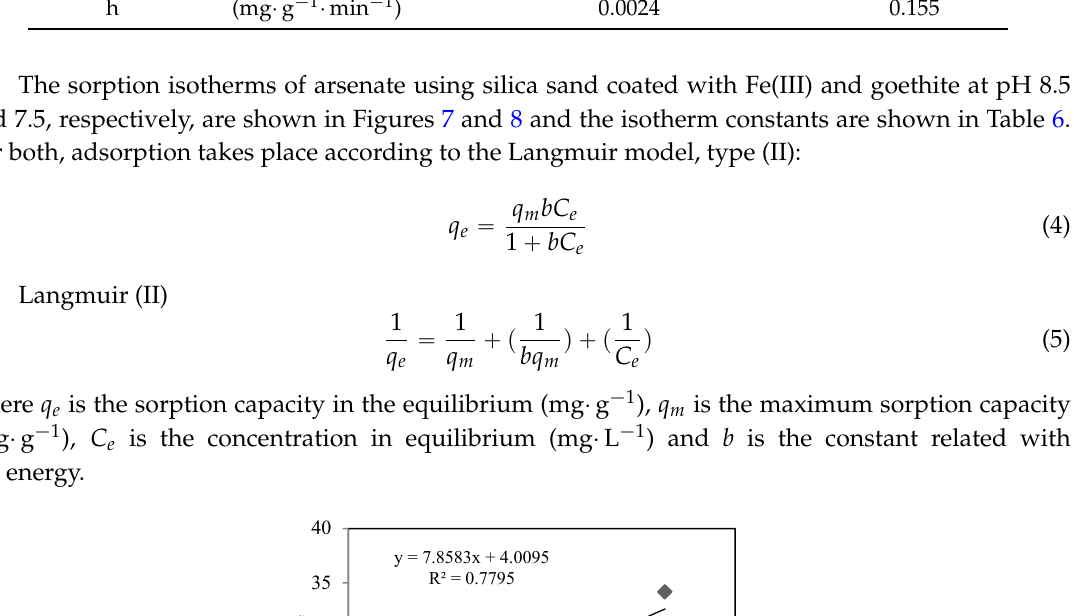
Table 5. Pseudo-second-order kinetic sorption constants.